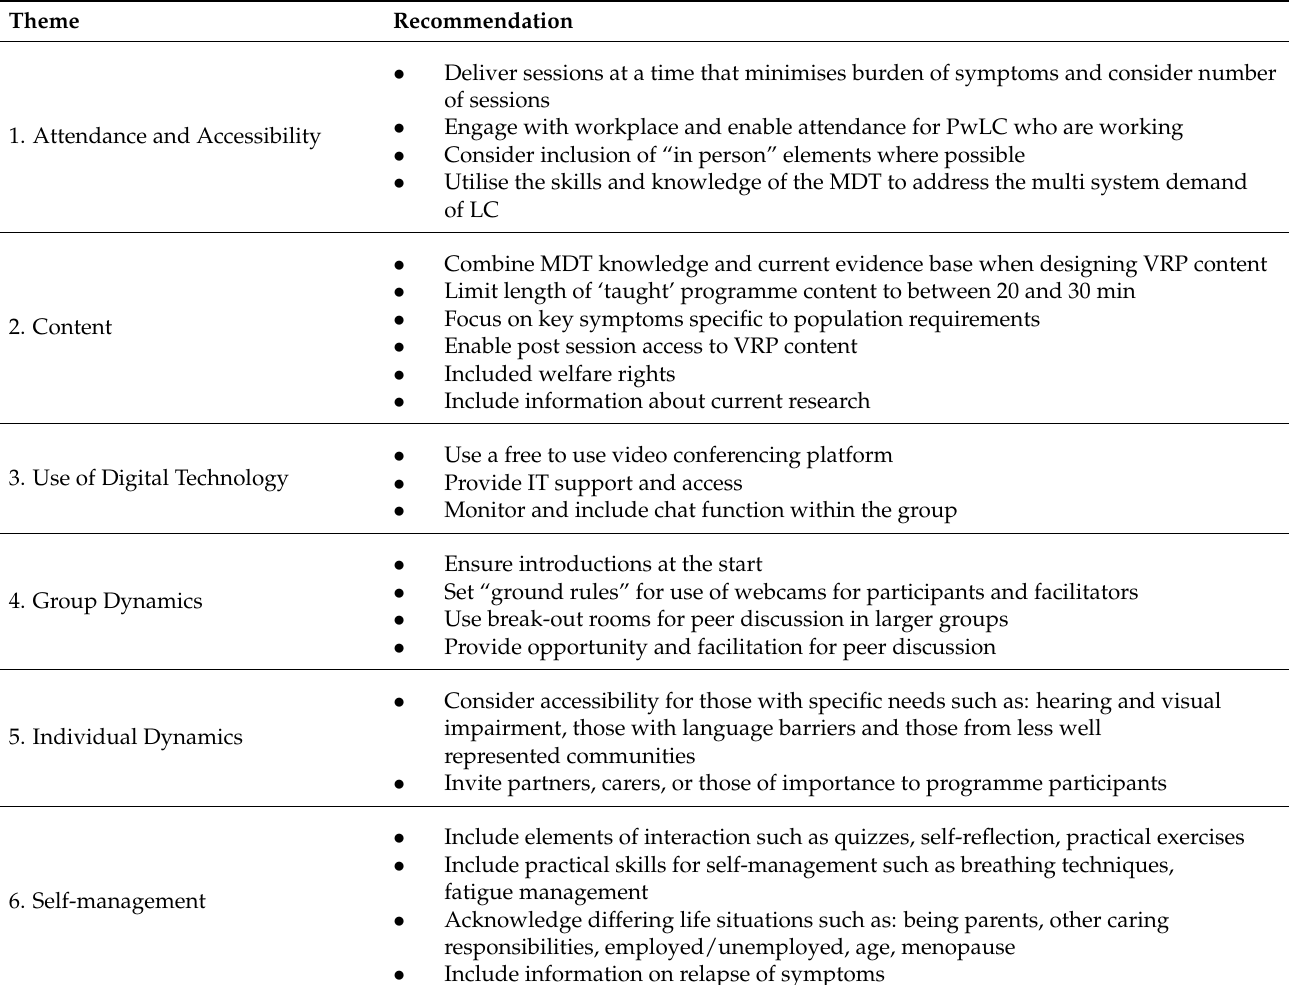
Table 3. Recommendations for the design of Virtual Rehabilitation Programme in Long COVID. Theme